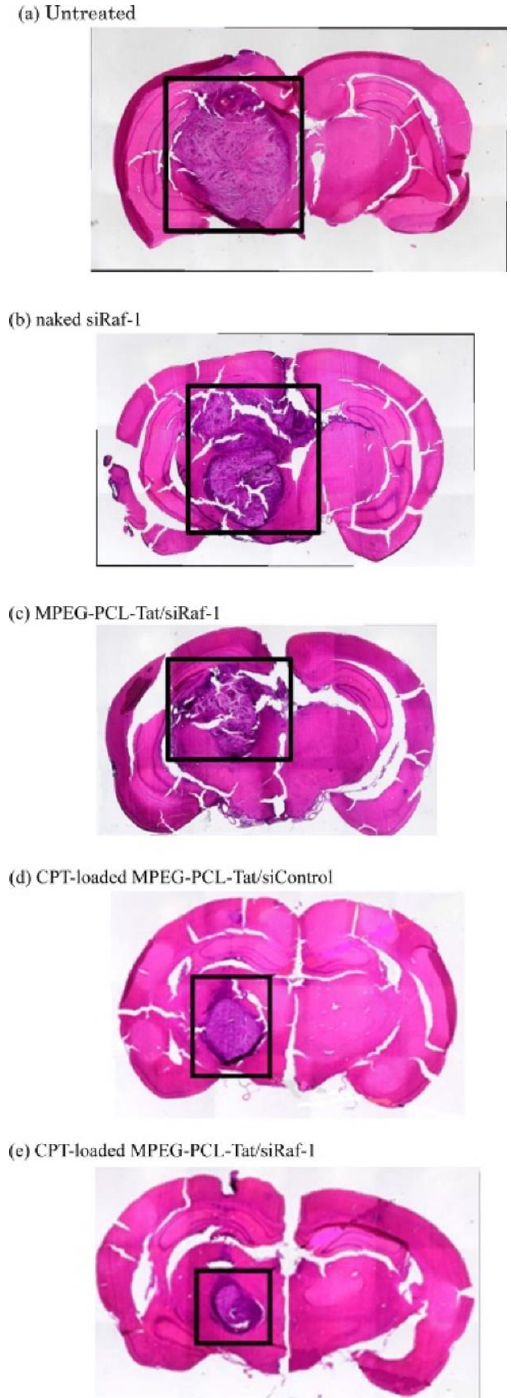
Figure 5. Photographs of HE-stained brain tissue in intracranial C6 glioma-bearing rats after intranasal administration of siRaf-1 complexed with camptothecin-loaded micelles. After 2 weeks, tissues were taken from untreated rats ( a ) and rats treated with naked siRaf-1 ( b ), methoxy poly(ethyleneglycol)-poly( ε -caprolactone) (MPEG-PCL-Tat/siRaf-1 complex) ( c ), CPT-loaded MPEG-PCL-Tat/siControl ( d ), and CPT-loaded MPEG-PCL-Tat/siRaf-1 ( e ). Adapted from Molecular Pharmaceutics with permission from the American Chemical Society, published by the American Chemical Society 2014, Copyright 2014 [13].